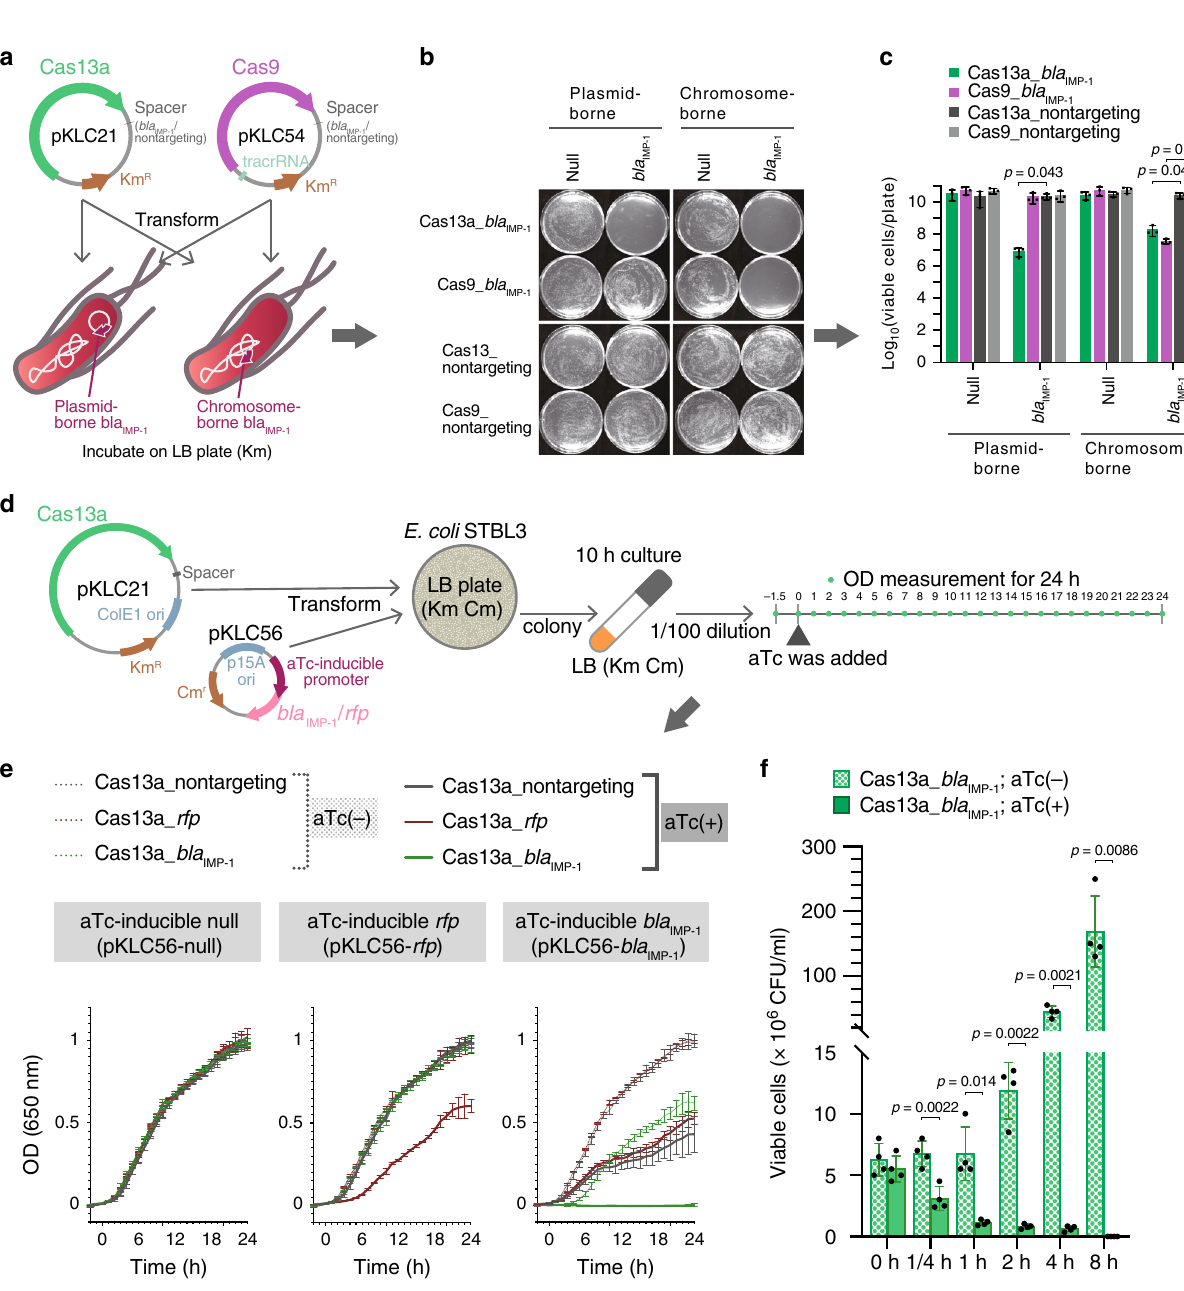
Fig. 1 Sequence-speci fi c bactericidal activity of CRISPR-Cas13a. a A schematic diagram of transformation of CRISPR-Cas13a and CRISPR-Cas9 with targeting bla IMP-1 into bla IMP-1 -expressing E. coli STBL3. b E. coli STBL3 expressing bla IMP-1 from a plasmid (plasmid-borne bla IMP-1 ) and